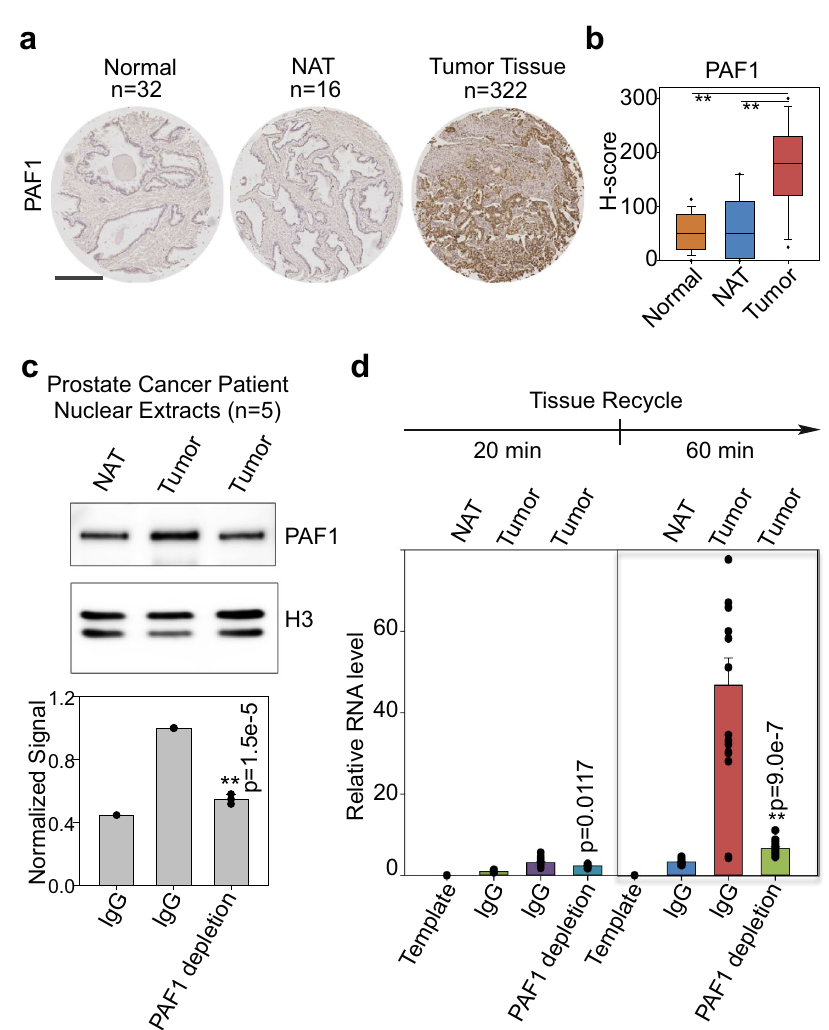
Fig. 5 PAF1 contributes to elevated tumor recycling. a Representative PAF1 immunoreactivity in normal prostate, non-tumor adjacent tissues (NAT), and tumor tissues. Scale bars: 500 μ m. b Slides were scanned using an Aperio Digital Pathology Slide Scanner (Leica Biosystems) at 20× magni fi cation. A box plot compares H-scores of PAF1 nuclear staining in 370 tissues. Box plots show median (center), 25th/75th percentiles (box bounds), 10th/90th percentiles (whiskers), and 5th/95th percentiles (outliers as symbols). The values beyond the outliers are not shown in the boxplot. The signi fi cance was determined by one-way ANOVA, ** p < 0.001. c Five prostate cancer tissues with paired NAT were used. Nuclear extracts of pooled tissues were incubated with PAF1 antibodies to moderately deplete PAF1 protein and then were analyzed by western blot. Histone H3 was used as an endogenous loading control. The graph shows the quanti fi cation of PAF1 expression. Values were expressed as the mean ± SEM of three independent experiments. d The transcription recycling assay was performed using pooled tissue nuclear extracts with or without PAF1 depletion. In vitro transcribed RNA products from the 2nd template during the Recycle step were analyzed by reverse transcription followed by qPCR quanti fi cation. Values were expressed as the mean ± SEM of three independent experiments. p -values were calculated using two-tailed Student ’ s t -test, ** p < 0.01. Source data are provided as a Source data fi